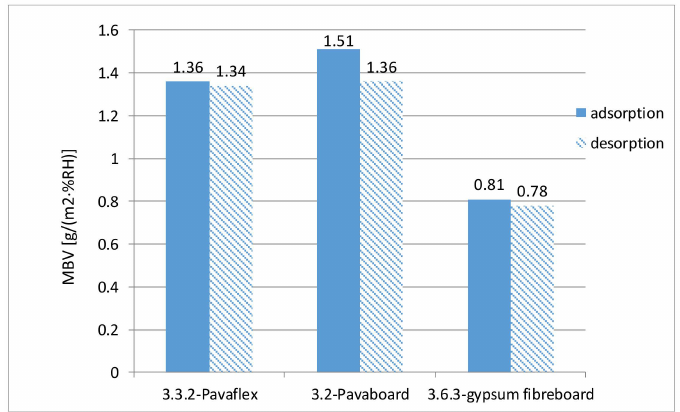
Figure 7. Measured changes in mass of individual materials during the adsorption and desorption phases over five 24-h cycles.